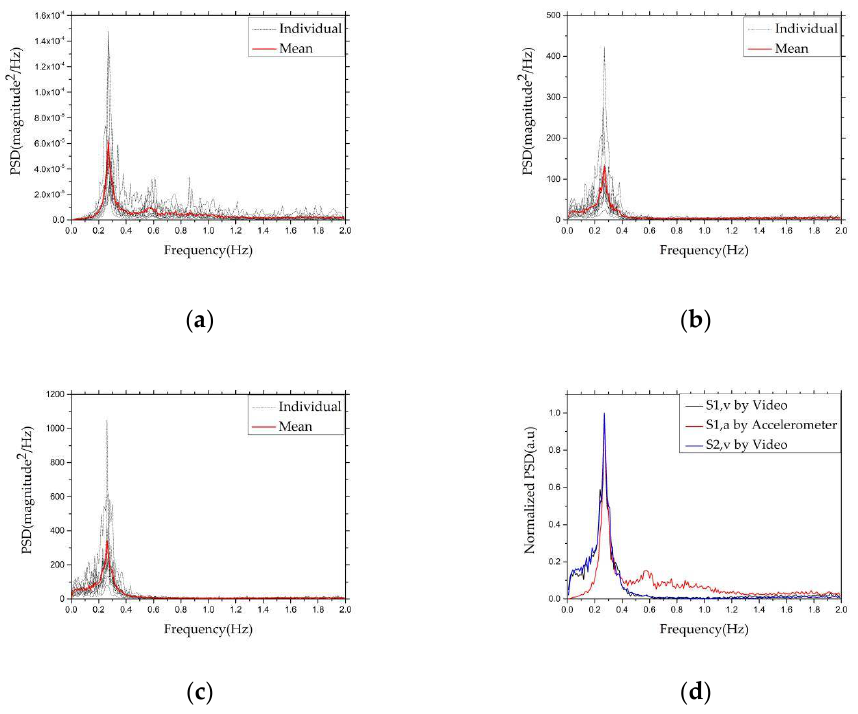
Figure 7. ( a ) The 10 groups of individual PSD of acceleration of S 1,a and their average PSD; ( b ) The 10 groups of individual PSD of velocity of S 1,v and their average PSD; ( c ) The 10 groups of individual PSD of velocity of S 2,v and their average PSD; ( d ) Normalized PSD of S 1,a , S 1,v , S 2,v